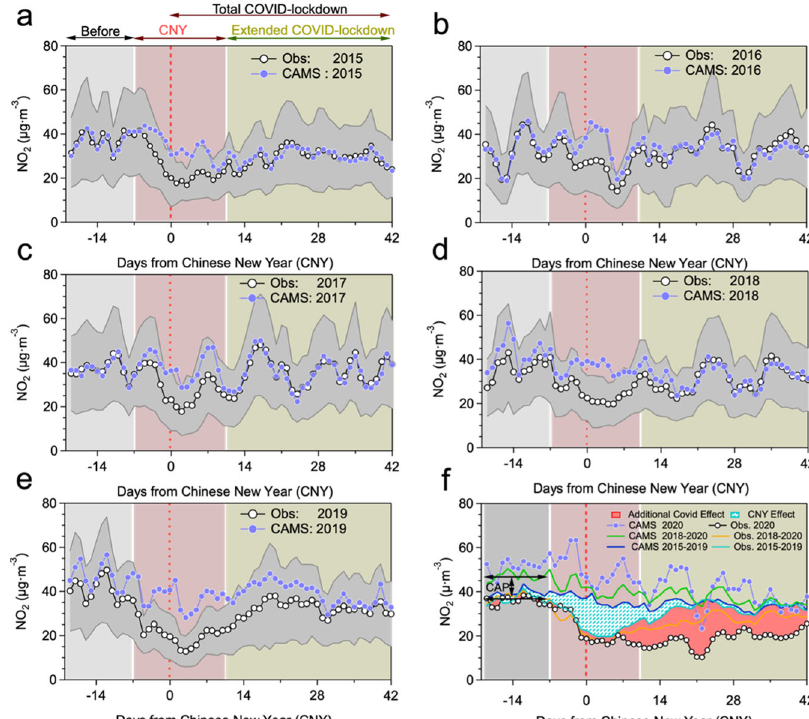
Fig. 1 Comparison between observations and CAMSRA for NO 2 across China. a – e show comparison results of the daily averaged NO 2 from observations and CAMSRA during the equivalent time of the 2020 COVID-lockdown from 2015 to 2019. f shows the comparison result in 2020 and additionally the corresponding data for the time average over 2015 to 2019 (blue line) and 2018 to 2020 (green line). The solid purple circle represents the average daily NO 2 concentration of CAMSRA, the black circle represents the average daily NO 2 concentration of observation across China, respectively. The red dash line represents the Chinese New Year ’ s day (CNY). Different background colors represent different time periods including “ Before CNY ” (gray shaded area) ranged from days − 21 to − 8 from the CNY ’ s day, “ CNY ” (red shaded area) ranged from days − 7 to + 10 from the CNY ’ s day, “ Extended COVID-lockdown ” (moss shade area) ranged from days + 11 to + 42 from the CNY ’ s day, and “ Total COVID-lockdown ” ranges from days − 1 to + 42 from the CNY ’ s day. The gap between the two black arrow lines represents the China ’ s Clean Air Plan effect